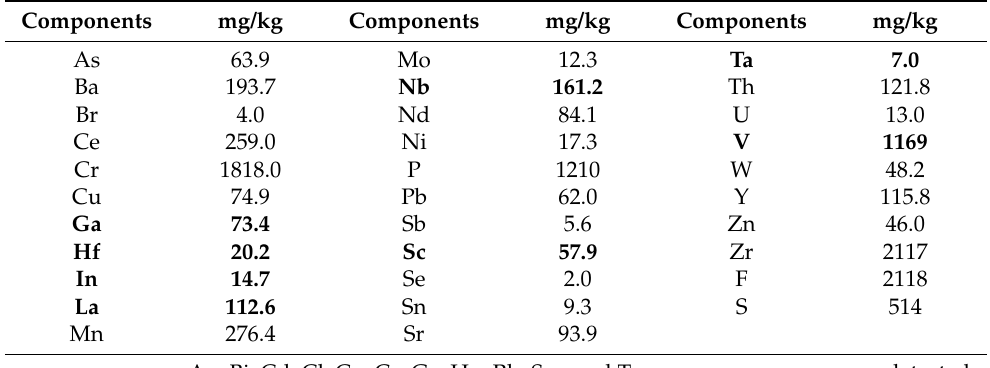
Table 1. Minor components of red